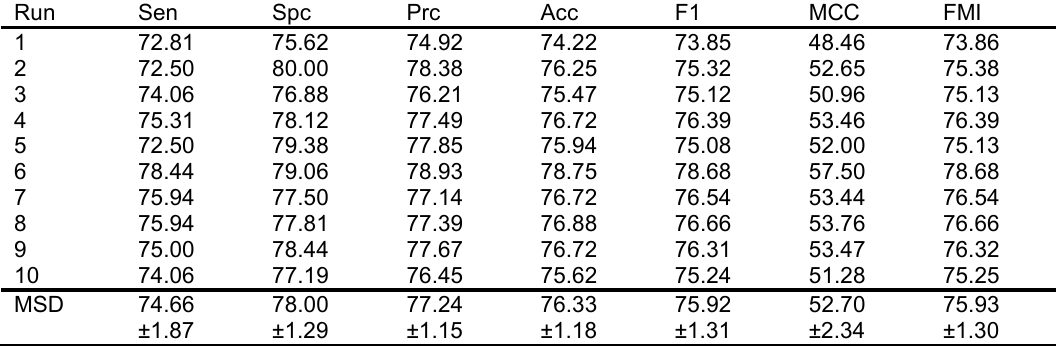
Table 4. Results of